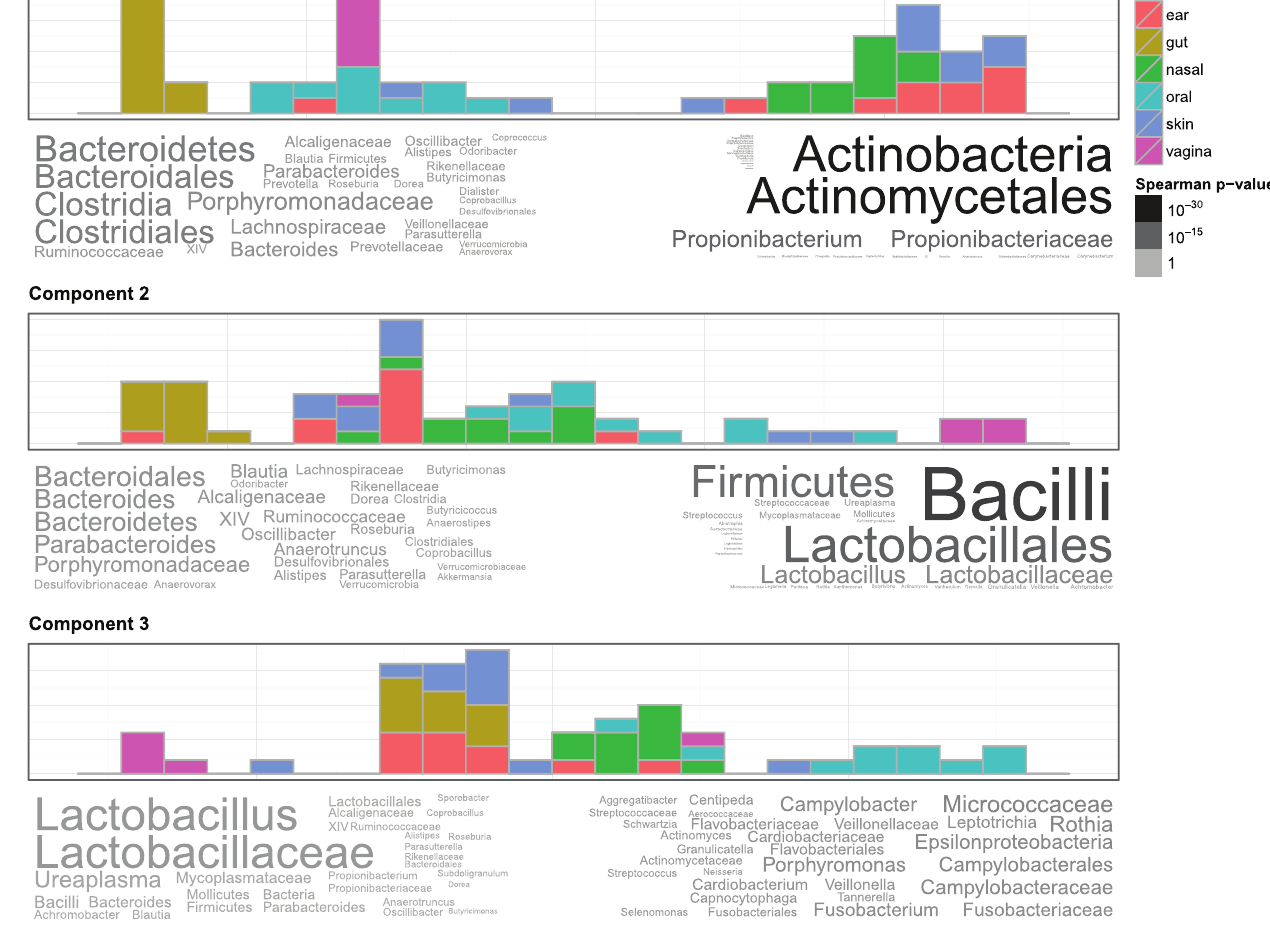
Figure 4. GOsummaries representation of PCoA on metagenomic data. Each component is described by a histogram showing the distribution of samples along the principal coordinate axis and word clouds showing most correlated features. The sizes and colours of the taxons in word clouds are proportional to - log of the Spearman rank correlation test p-value. The right and left word clouds represent taxons 10 that were significantly either correlated or anti-correlated respectively with the principal